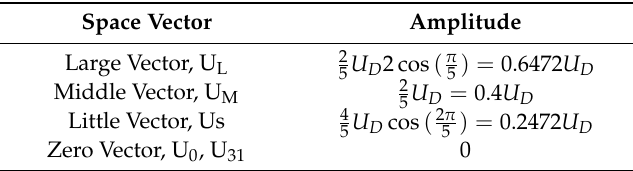
Table 1. Amplitude of the voltage vector for a five-phase inverter.